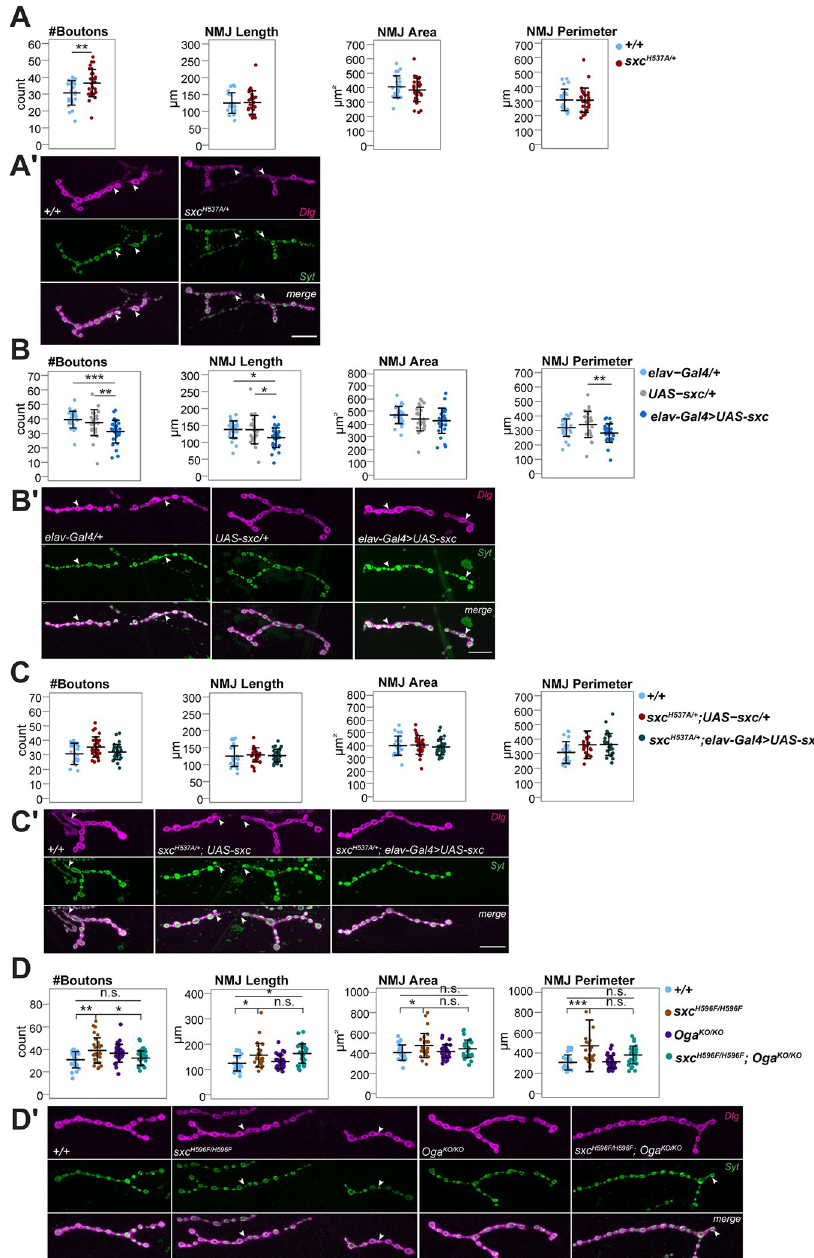
Fig 2. Both reduced and increased O-GlcNAc transferase activity in neurons cause defects in synaptic morphology. Data presented as individual data points with mean ± SD. (A) NMJs on muscle 4 of sxc H537A/+ larvae have a significantly higher number of synaptic boutons (N = 29, in red) as compared to their genetic background control ( +/+ , N = 24, p = 0.009, in blue,) but not significantly different NMJ length ( p = 0.872), area ( p = 0.314) and perimeter ( p = 0.935). �� p < 0.01, based on one-way ANOVA. (B) Elav-Gal4 > UAS-sxc larvae have a significantly lower number of boutons (N = 29, in dark blue) compared to their respective background controls elav-Gal4/+ (N = 30, p adj = 2.1x10 -4 , in light blue) and UAS-sxc/+ (N = 26, p adj = 0.009, in grey), significantly reduced NMJ length ( p adj/ = elav-Gal4 0.013, p adj/ = 0.02) and a smaller NMJ perimeter ( p adj/ = 0.008). (C) Neuron-selective expression of sxc in UAS-sxc UAS-sxc sxc H537A/+ larvae shows no change in bouton numbers ( sxc H537A/+ ; elav-Gal4 > UAS-sxc (N = 29, in green)), compared to sxc H537A/+ , UAS-sxc/+ larvae (N = 28, p adj = 0.102, in red) and compared to control (N = 27, p adj = 0.977, in blue) and no change in NMJ length compared to control ( +/+ , N = 28, p adj = 0.974) and sxc H537A/+ , UAS-sxc/+ larvae ( p adj = 0.935). Also NMJ area ( p adj = 0.849, p adj 0.691) and NMJ perimeter were not changed ( p adj /control /sxcH537A; UAS-sxc/+ = / control = 0.066), p adj/ sxcH537A; UAS-sxc/+ = 0.995). (D) Number of synaptic boutons ( p adj = 0.003), NMJ length ( p adj = 0.01),